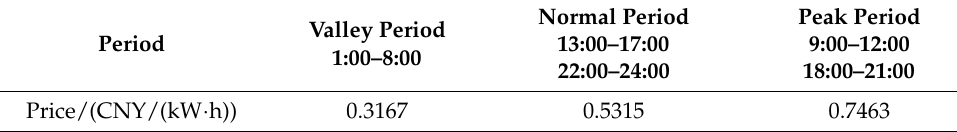
Table 3. Time-of-use period and price parameters.